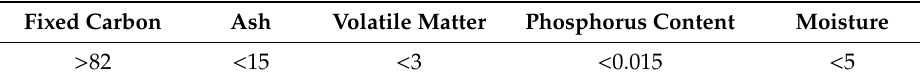
Table 2. Chemical composition of toner (mass